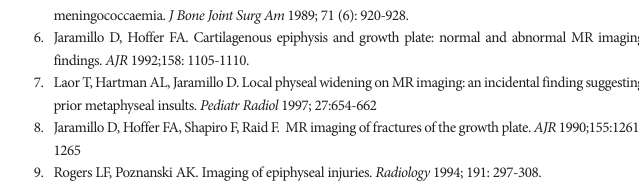
Fig. 6. Flame-shaped projections of the physeal cartilage into the adjacent metaphysis are demonstrated in both postinfective and post-traumatic physeal injury and are considered as features in keeping with a physeal bar seen in this patient on gradient echo (a) and T1-weighted imaging (b).